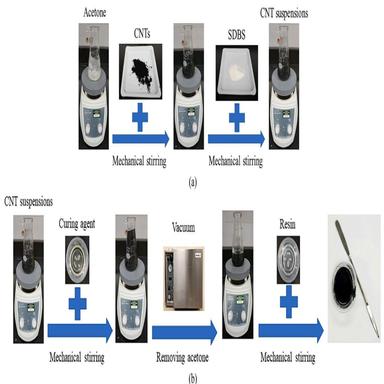
The complete mixing procedures: (a) CNT suspensions; (b) CNT reinforced epoxy composites.